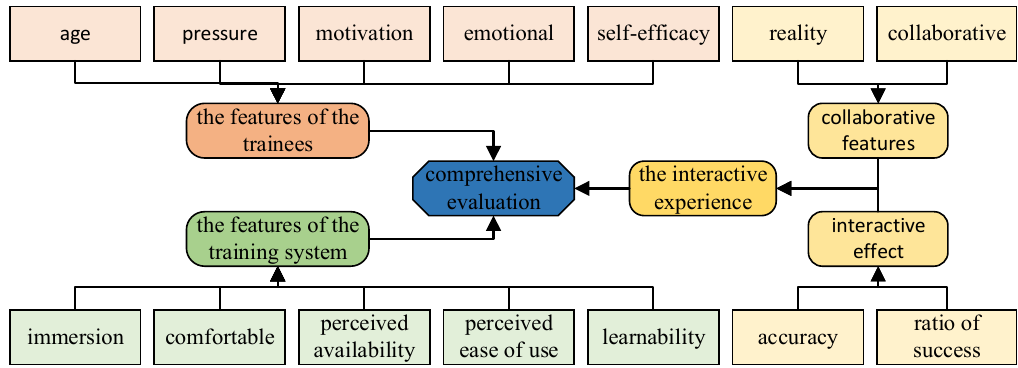
Figure 4. The indicators that affect the comprehensive evaluation results.